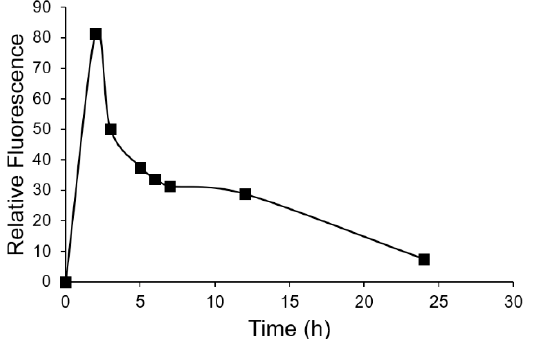
Figure 5. Quantitation of urine fluorescence after administration of UreterGlow-11. Mice were administered 10 nmol of various conjugates ( n = 1 per time point) via tail vein injection. After varying times, mice were euthanized, and urine was collected from their bladders. The fluorescence of the isolated urine was quantitated.